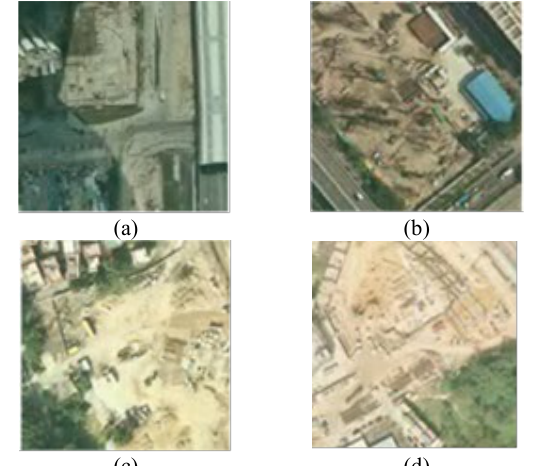
Figure 3 Qualitative analysis sample examples (all of them are construction bare land scenes)